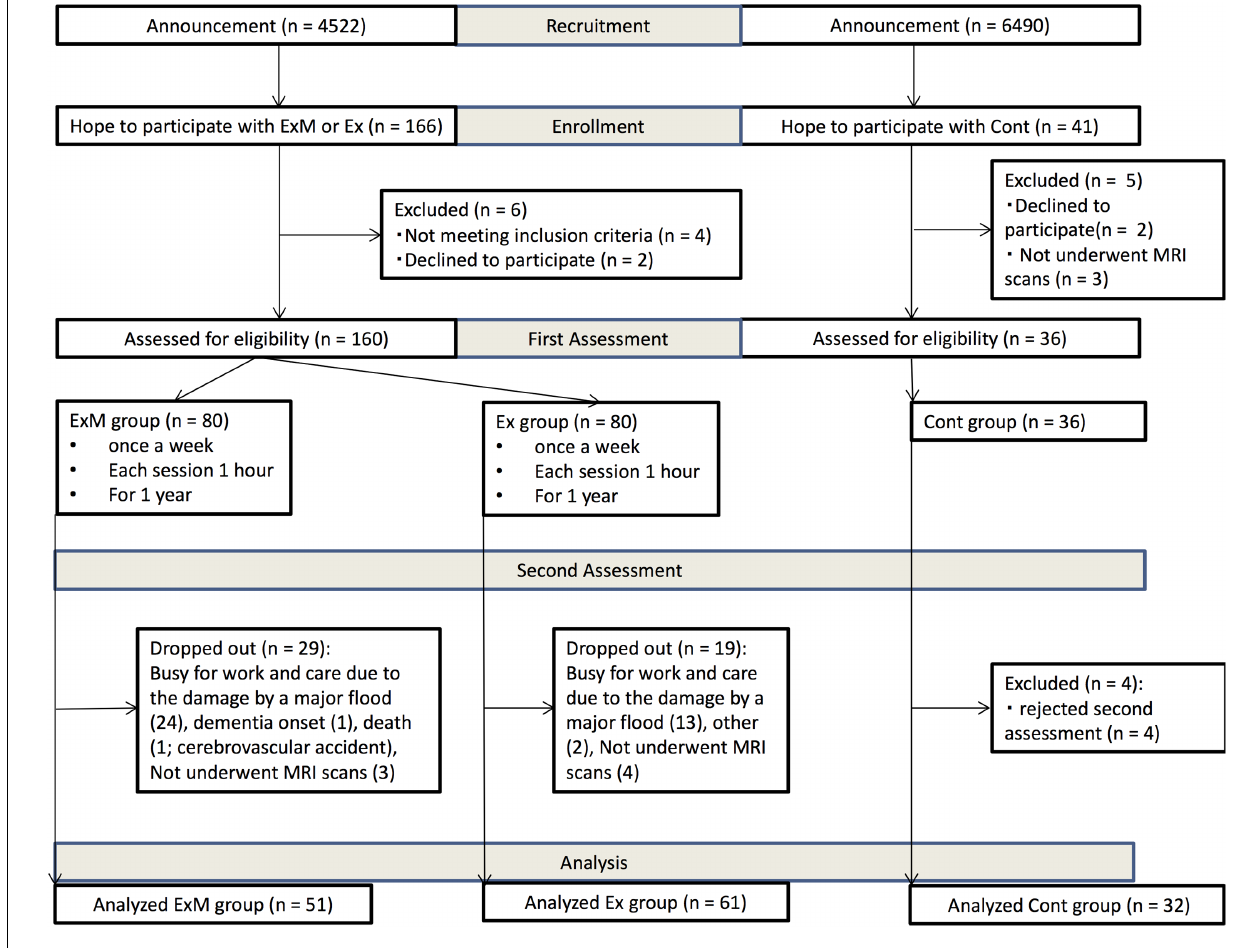
FIGURE 1 | Recruitment flow chart. Cont, control group; Ex, physical exercise without music group; ExM, physical exercise with music